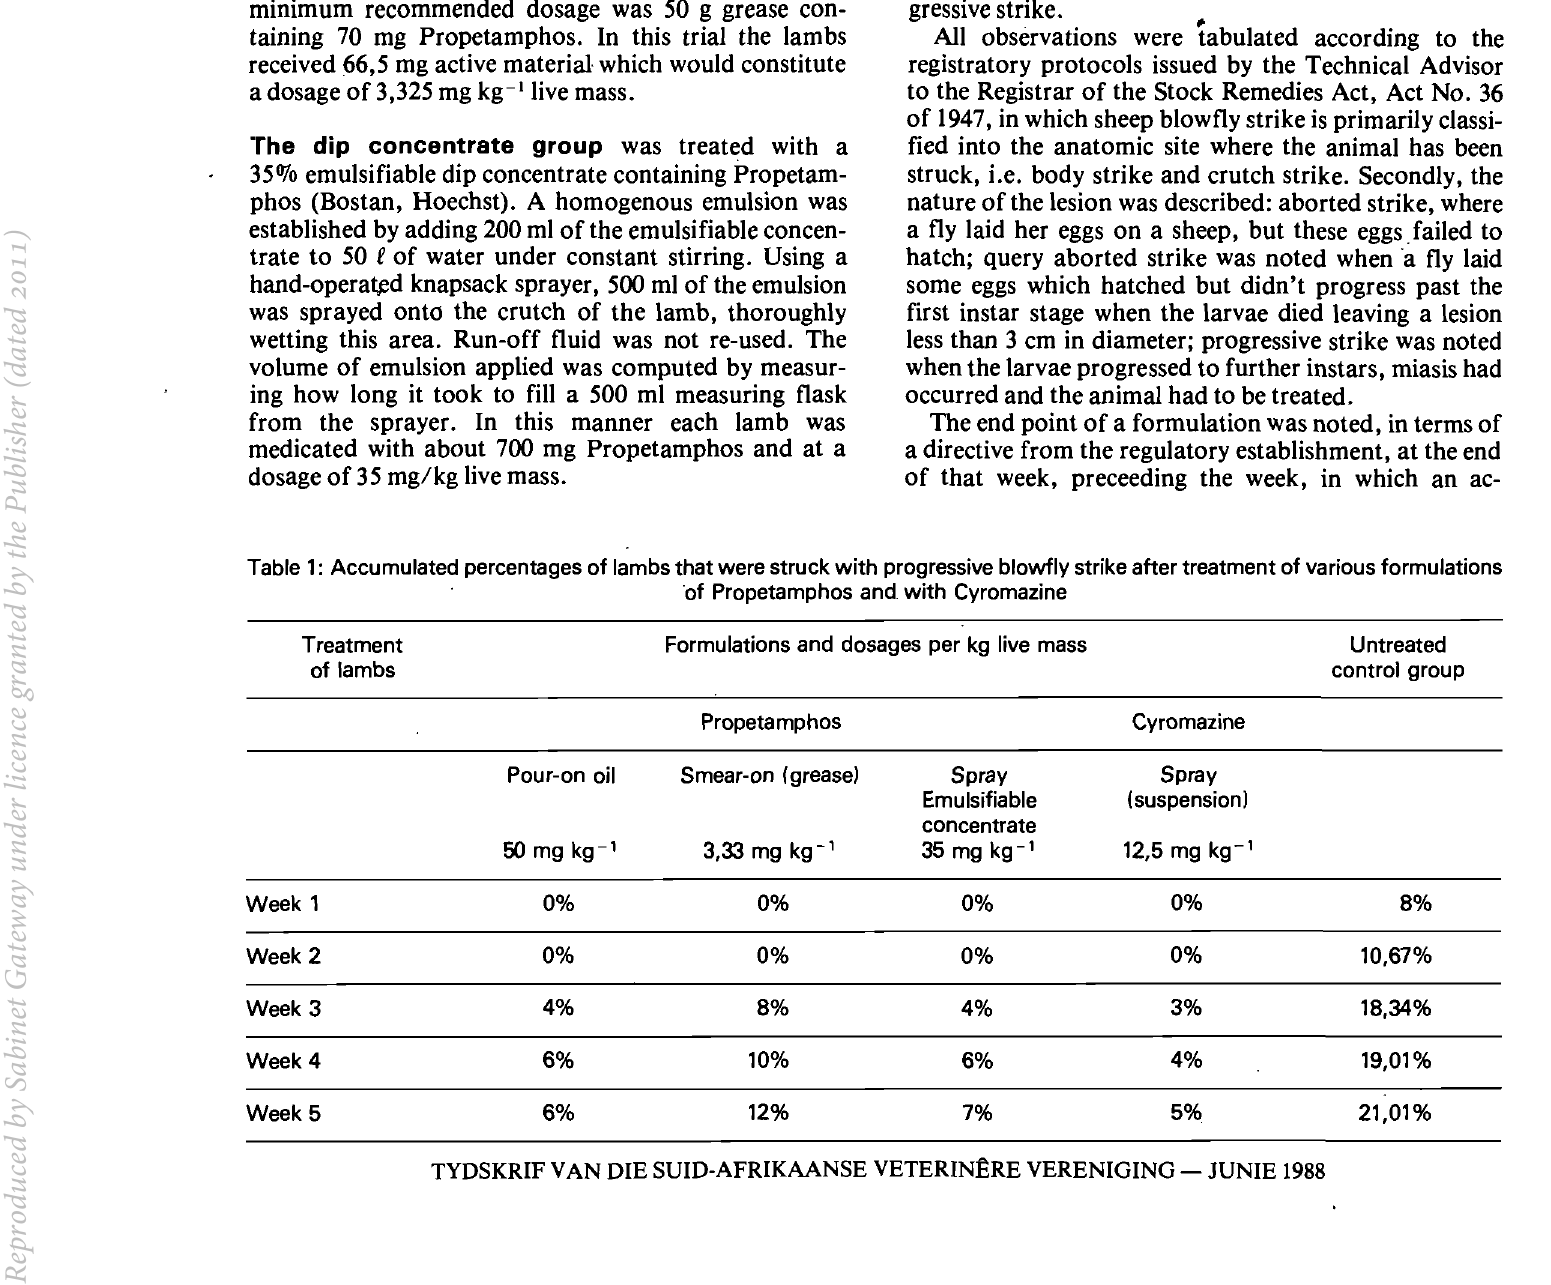
Table 1: Accumulated percentages of lambs that were struck with progressive blowfly strike after treatment of various formulations of Propetamphos and with Cyromazine